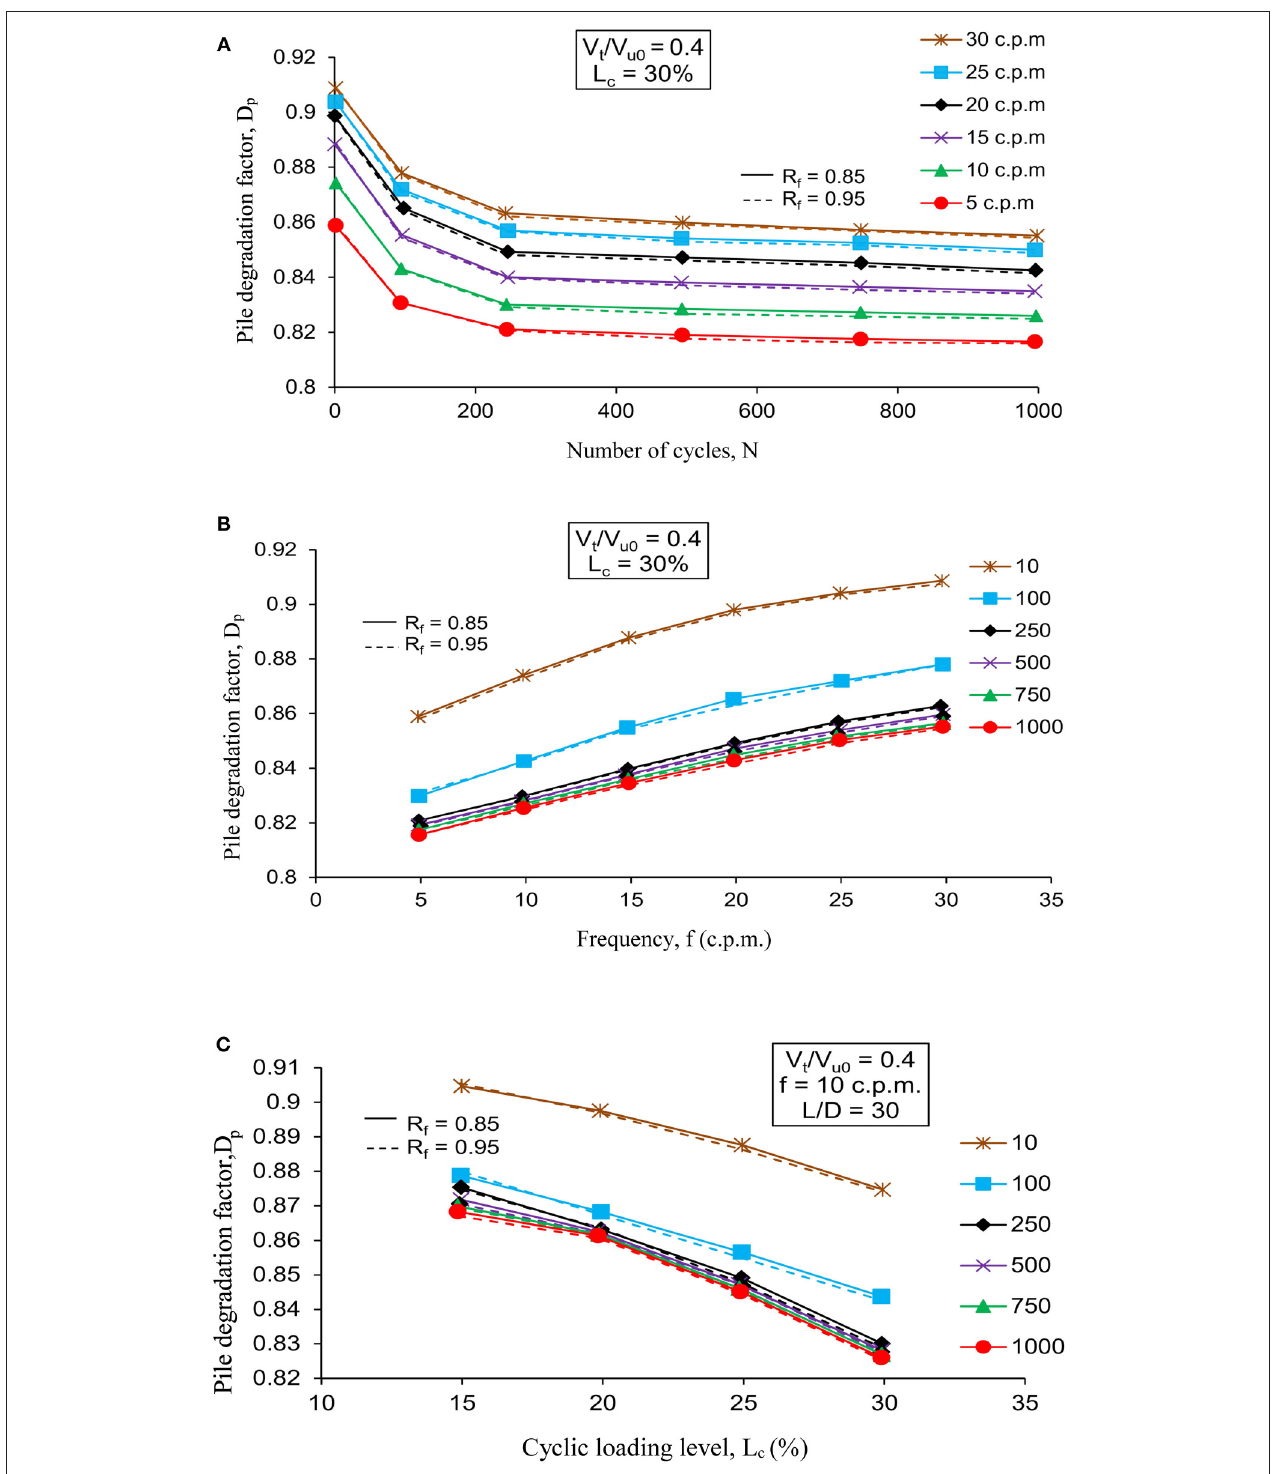
FIGURE 6 | Variation of pile degradation factor with: (A) , N (B) , f (C) , L C .